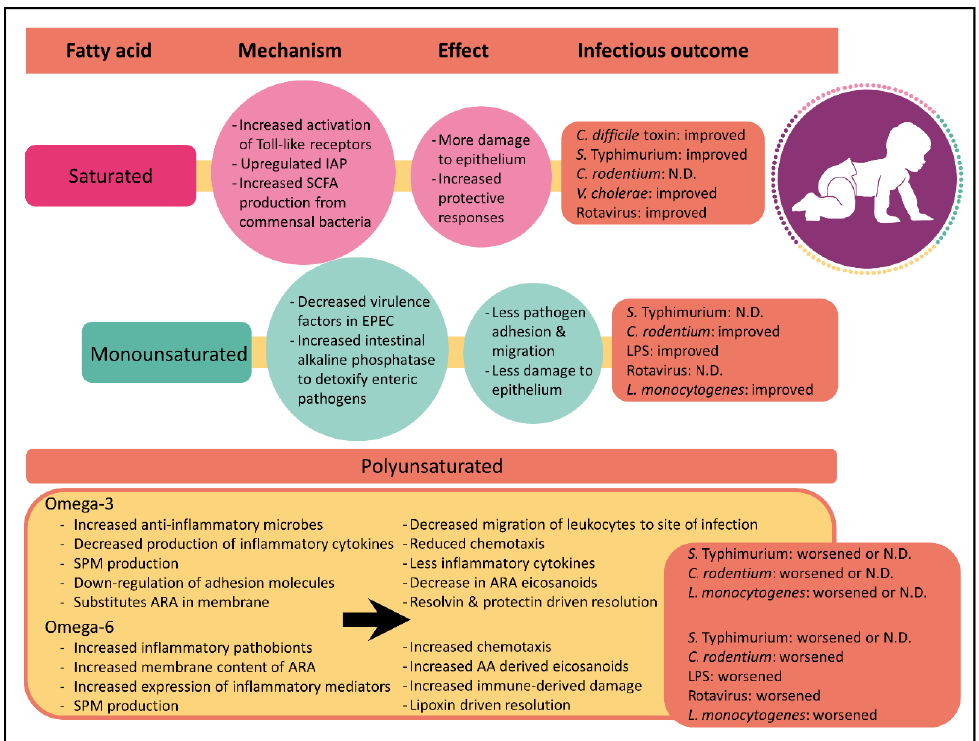
Figure 1. Summary of mechanistic insights, inflammatory effects and enteric disease outcomes driven by saturated, monounsaturated and polyunsaturated fatty acids. Improved, worsened or no difference (N.D) describes the severity of diarrheal infectious outcomes when compared to other diets tested. If two studies had conflicting results, both outcomes are listed. Abbreviations: IAP, intestinal alkaline phosphatase; SPM, specialized pro-resolving lipid mediators; SCFA, short-chain fatty acids; LPS, lipopolysaccharide; ARA, arachidonic acid; EPEC, Enteropathogenic Escherichia coli .